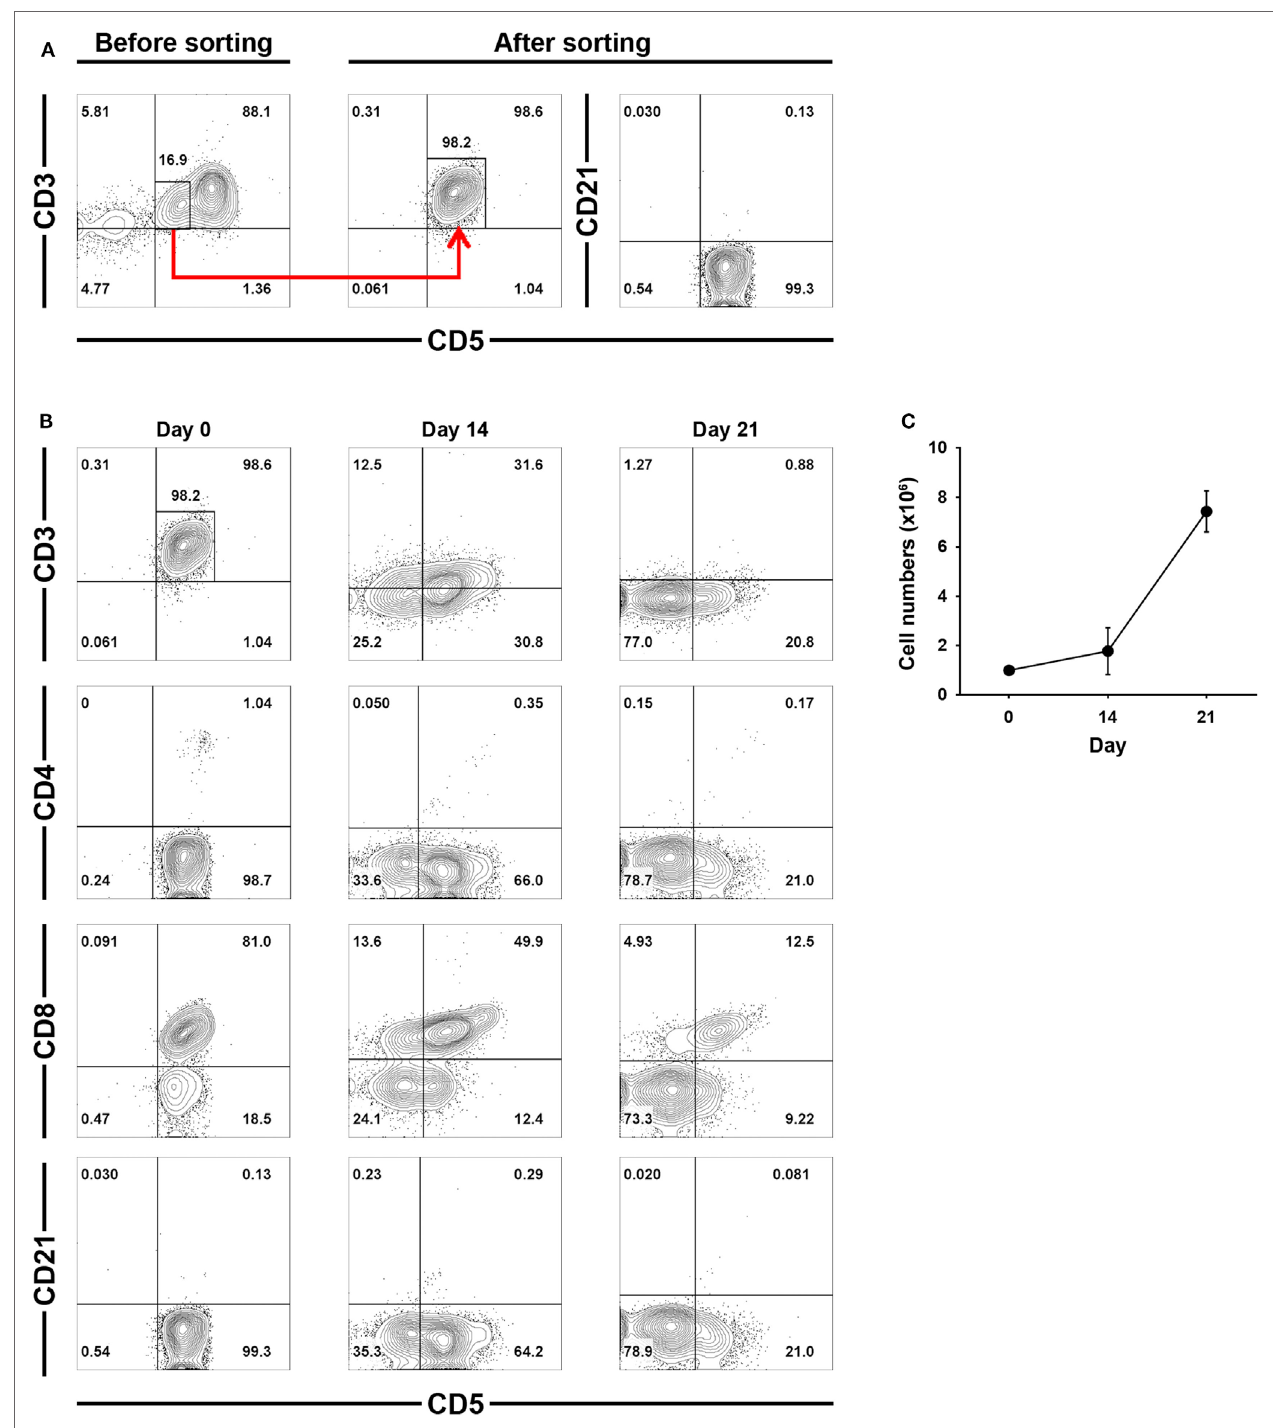
FigUre 3 | Phenotypic changes of purified CD3 + CD5 dim CD21 − cells during culture for 21 days. (a) CD3 + CD5 dim CD21 − cells were purified from freshly isolated PBMCs using a cell sorter. The purity of CD3 + CD5 dim CD21 − cells after sorting was more than 98% ( n = 5). (B) Phenotypic analysis of the purified CD3 + CD5 dim CD21 − cells during culture for 21 days. CD3 − CD5 − CD21 − cells were proliferated from purified CD3 + CD5 dim CD21 − cells, and the majority of expanded cells in culture were CD3 − CD5 − CD21 − after 21 days. The phenotype of most of these expanded CD3 − CD5 − CD21 − cells was CD4 − CD8 + / − after 21 days of stimulation. The results shown are representative results from one of five different donors. (c) The rate of proliferation was calculated by counting the total number of viable cells in culture. Values represent the mean ± SD ( n = 5).